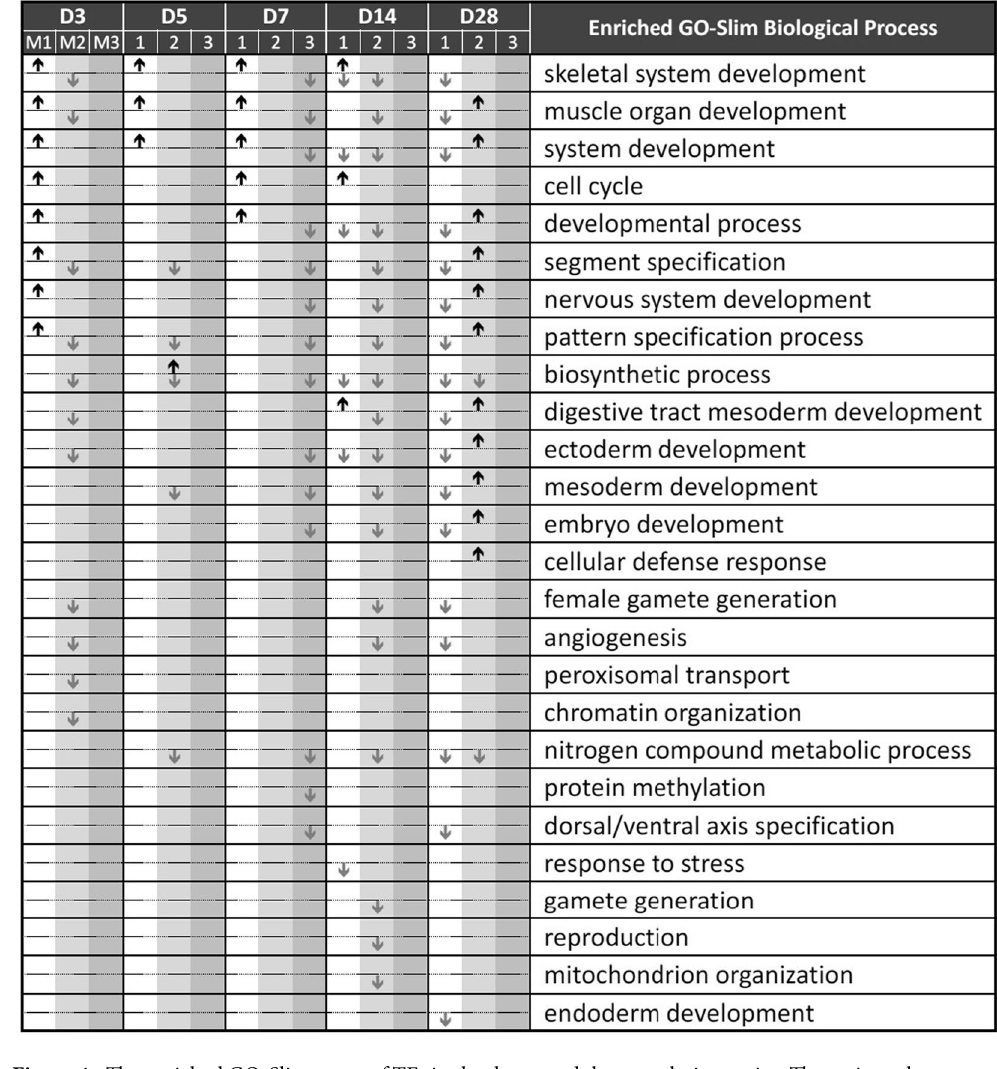
represent Modules 1, 2, and 3. The rows give the GO-Slim descriptions. The up and down arrows represent the GO-Slim in the row enriched (FDR < 0.05) for up- and down-regulated DE TF genes of the modules at the time